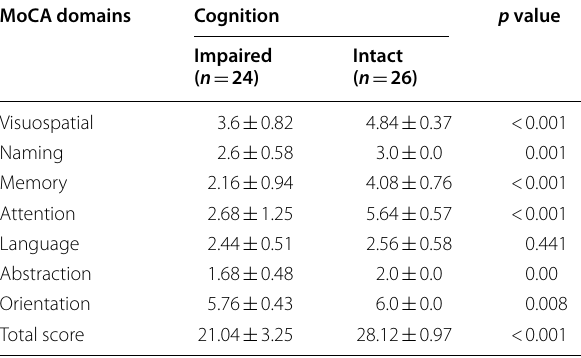
Table 4 Cognitive subdomains in patients with multiple sclerosis according to MoCA